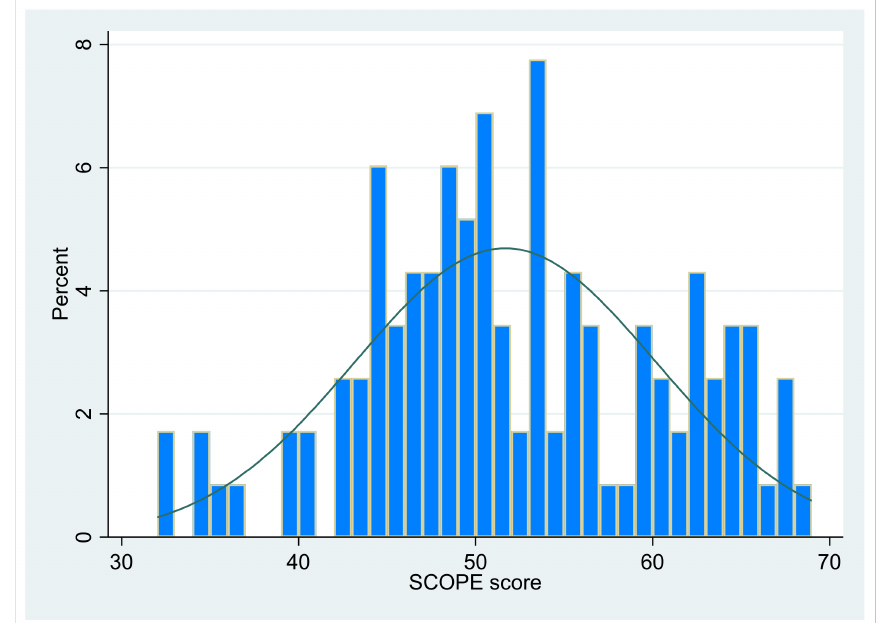
Figure 2. Global score distribution; extreme scores: 32 (1.72%), 69